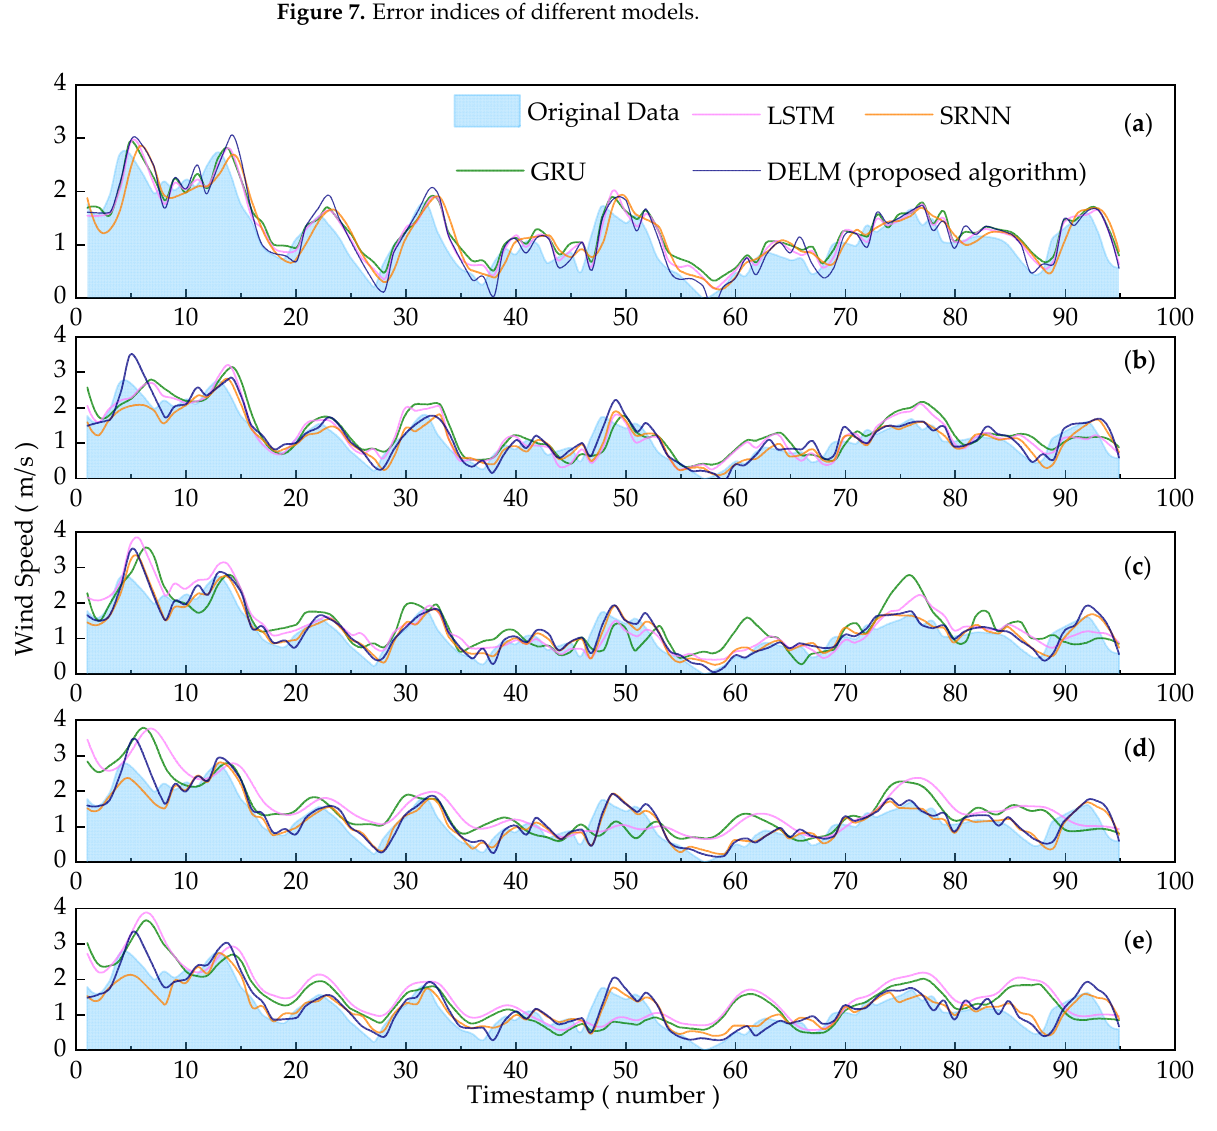
Figure 8. Fitting lines of different models with input dimensions from 1 to 5: ( a ) 1D input set; ( b ) 2D input set; ( c ) 3D input set; ( d ) 4D input set; ( e ) 5D input